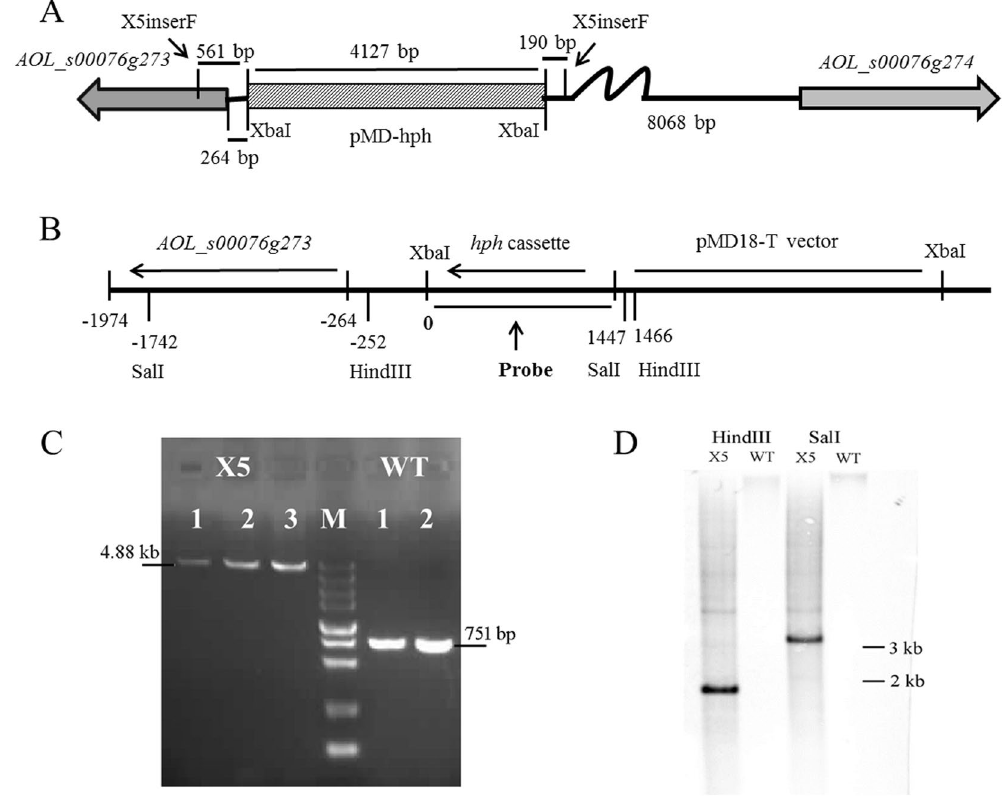
Figure 2. Identification and verification of the insertion of the hph cassette in transformants X5. ( A ) The sketch map of the insertion of the pMD-hph in transformants X5. The frame filled with diagonal lines presented the insertion of pMD-hph, and the X5inserF and X5inserR indicated the location of primers used for the PCR verification in Fig. 2C. ( B ) The schematic diagram of the location of gene 76g273 and the pMD-hph in X5, and restriction enzymes (SalI and HindIII) used for Southern blotting analysis were also indicated. The inserted site of the pMD-hph was set to 0, and the expected size of band hybridizing to the hph cassette in the X5 was 3189 bp and 1718 bp after digested by SalI and HindIII, respectively. ( C ) Verification of the insertion of the hph cassette in transformants X5 by PCR amplification using primers X5inserF/X5inserR. M, DNA marker, ladders are 5 kb, 3 kb, 2 kb, 1.5 kb, 1 kb, 750 bp, 500 bp, 250 bp and 100 bp. ( D ) Southern blotting analysis of the WT and X5 using restriction enzymes SalI and